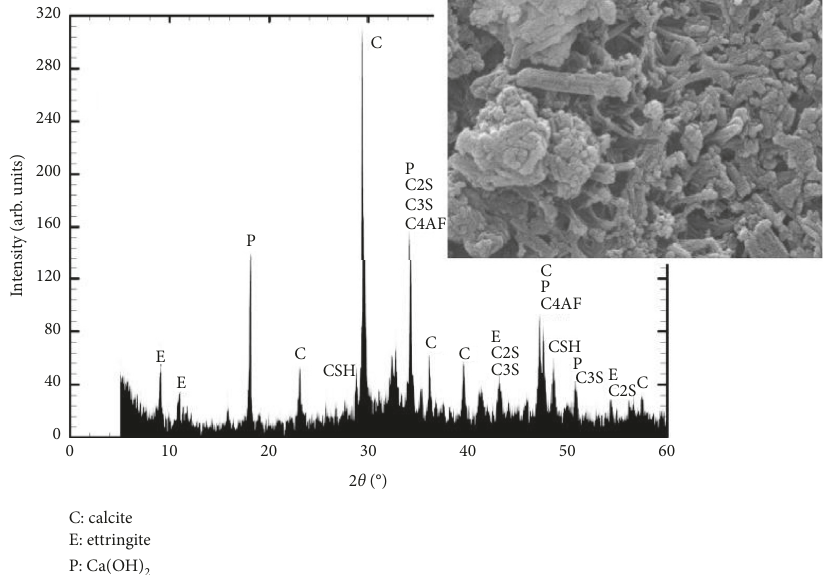
Figure 10: SEM micrographs and XRD patterns of cement-marble powder paste